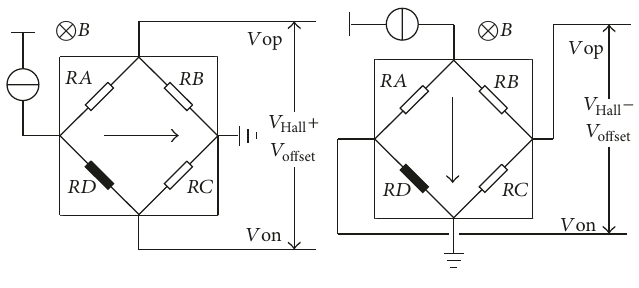
Figure 4: Spinning current technology.